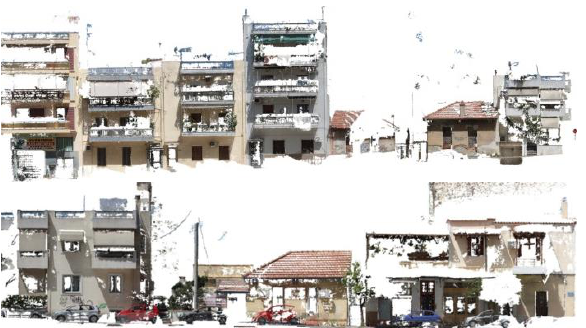
Figure 5. Orthoimages of two sides of an urban block of interest Instead of the acquisition of terrestrial images of the building façades, low altitude UAV images may also be acquired. Such parts of buildings that are not visible from street